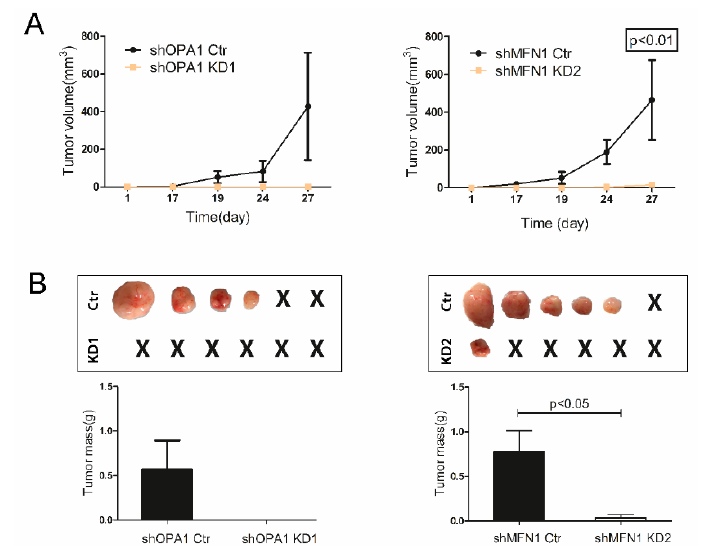
Figure 4. Mitochondrial fusion dysfunction inhibited tumor formation and growth in vivo. ( A ) Huh7 shOPA1 and control cells were injected subcutaneously into nude mice. Tumor size was measured at post-injection days 1/17/19/24/27 (n = 4 pairs). Huh7 shMFN1 and control cells were injected and tumor size was measured in the same way (n = 5 pairs). ( B ) Tumors were harvested from nude mice at day 27 and weighed. Histograms show means ± SEM with p value derived by the Mann Whitney test.